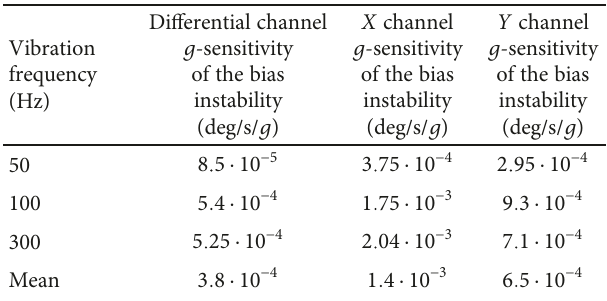
Figure 12: Bias instability for di ff erent vibration parameters. Table 2: g -sensitivity of the bias instability to vibration